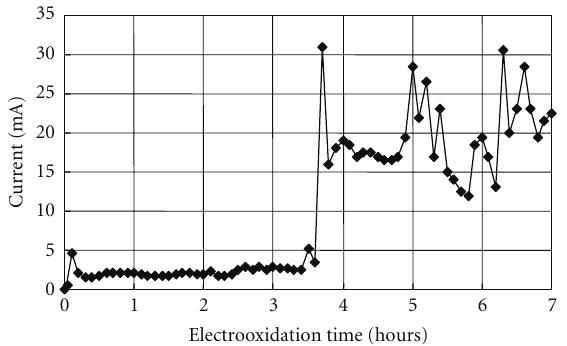
Figure 2: Current changes as a function of electrooxidation times. on the substrate perpendicular to the two electrodes by the applied electric field, it is unlikely that all the molecules between two electrodes are